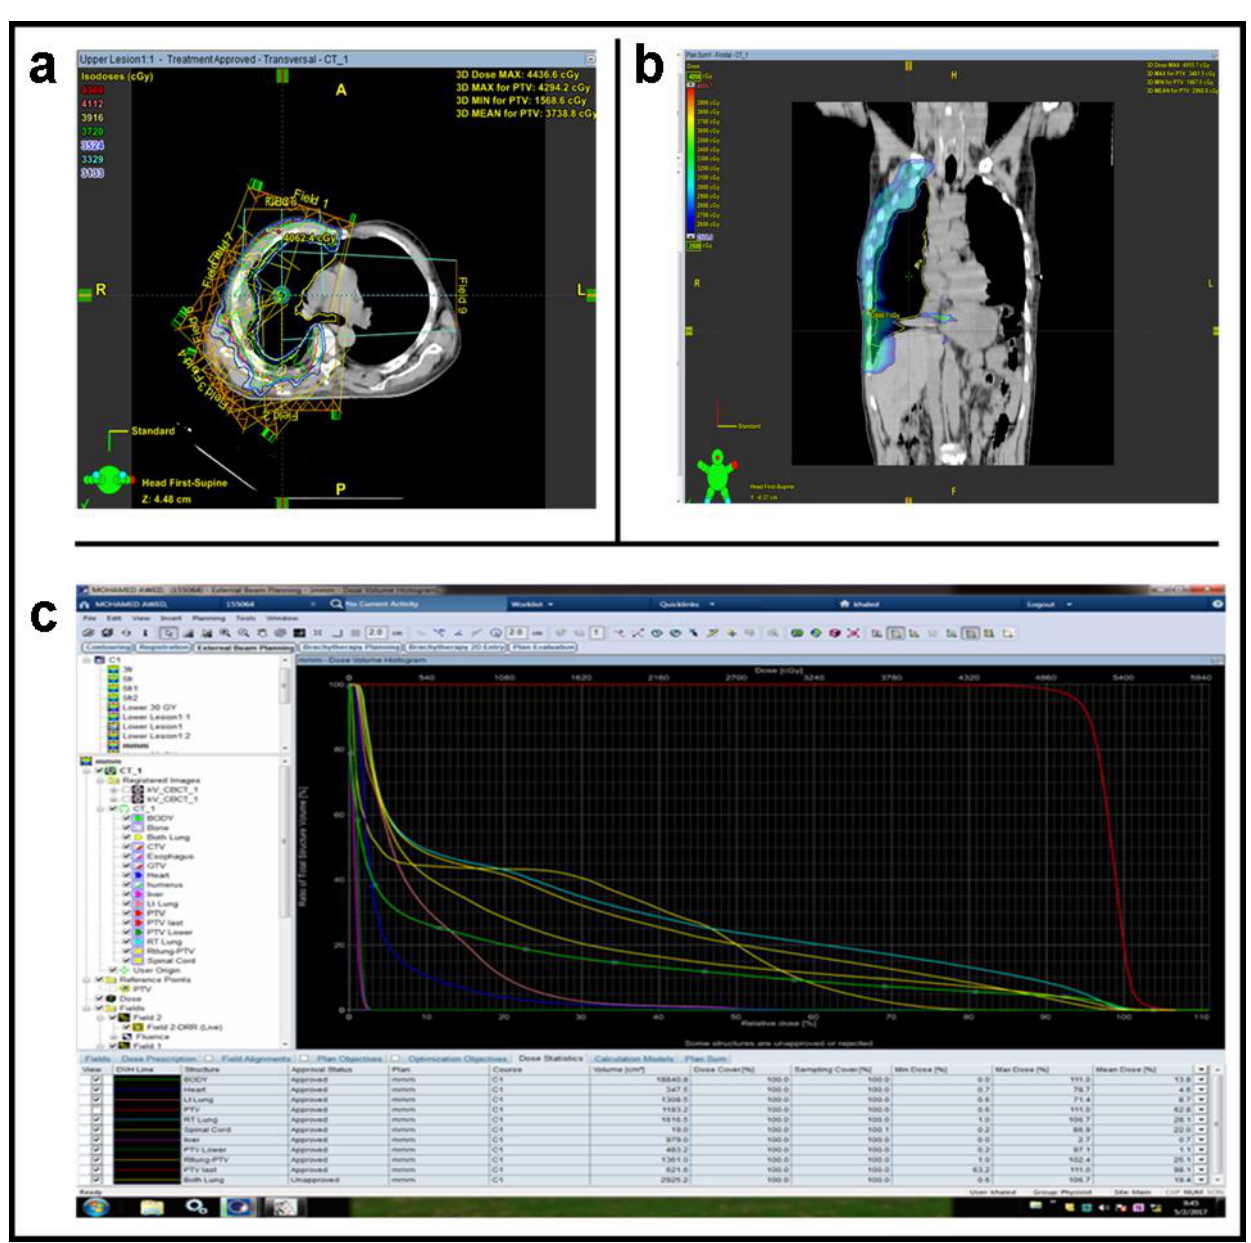
Figure 3 . a : Eight fields of step and shoot IMRT in a 50 years old male patient with right side malignant pleural mesothelioma, epithelioid type. The patient received systemic chemotherapy with pemetrexed and ciplatin for total 6 cycles and he was not candidate for surgery, b : Dose distribution in a coronal section demonstrating homogenous dose distribution. Mean dose to the PTV=2960.8 cGy, c : Dose volume histogram demonstrating acceptable normal tissue dose